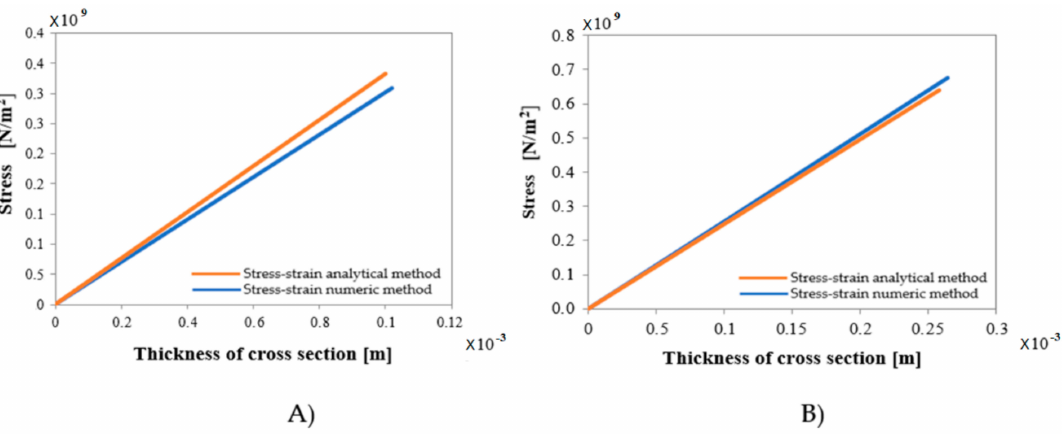
Figure 23. Analytically and numerically computed stresses and deformations. ( A ) MF. ( B ) MH.